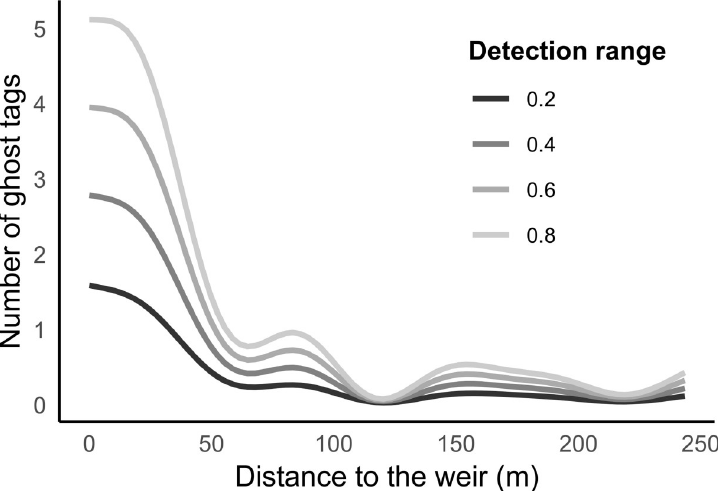
Fig 3. The GAM model assessing the number of ghost tags within antenna detection range related to distance from the weir. The ghost PIT presence in the antenna reading range can cause reading collisions and an inability to detect living